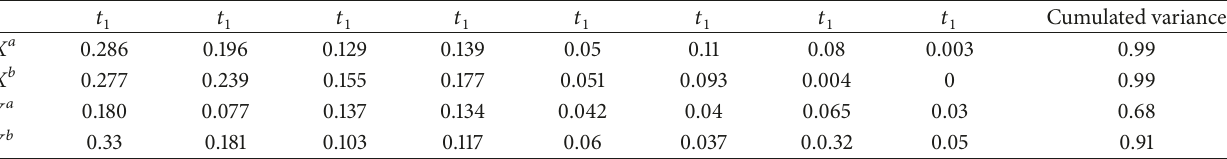
Table 1: Comparison between explained variance of proposed robust quadratic PLS and original quadratic PLS in cosmetic